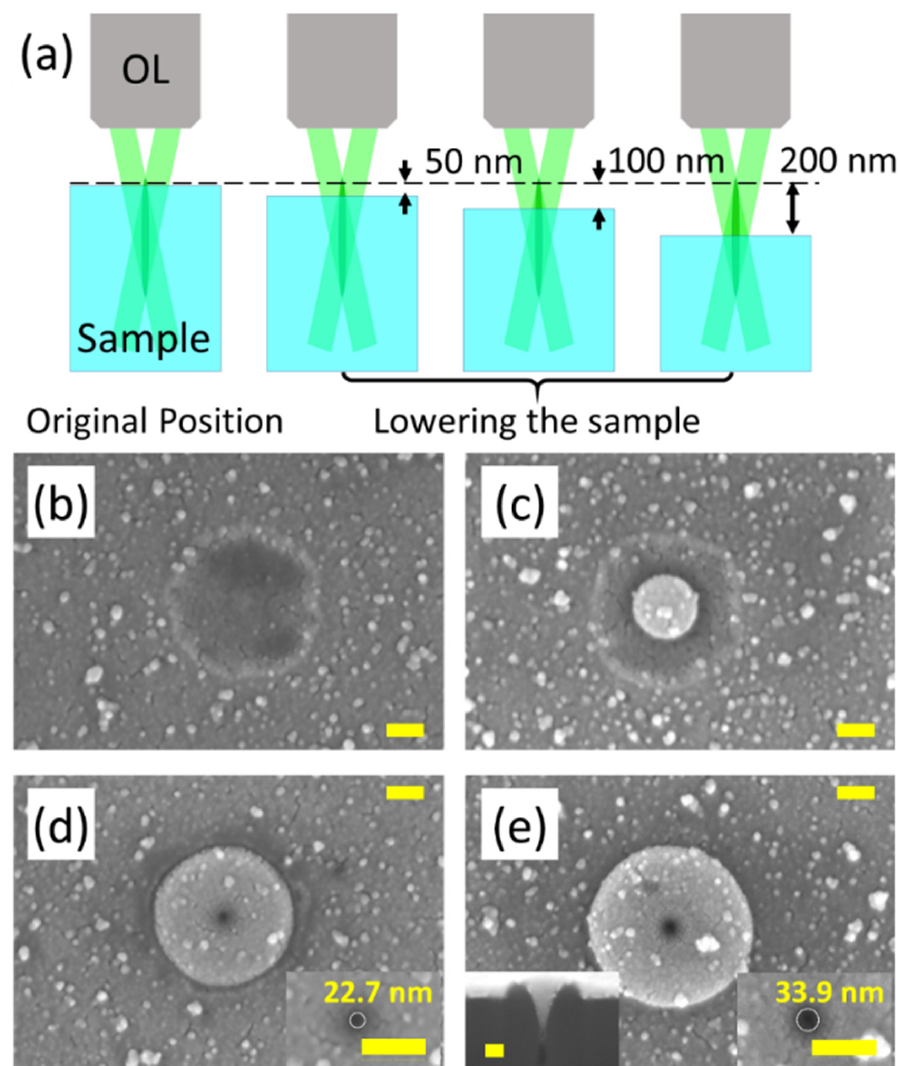
Figure 2e. A cross-section image of the plate-hole structures in Figure 2d,e is shown in the inserted image of Figure 2e. The “plate” is a funnel shape structure from a cross section view with a nano-hole in the bottom of the funnel.